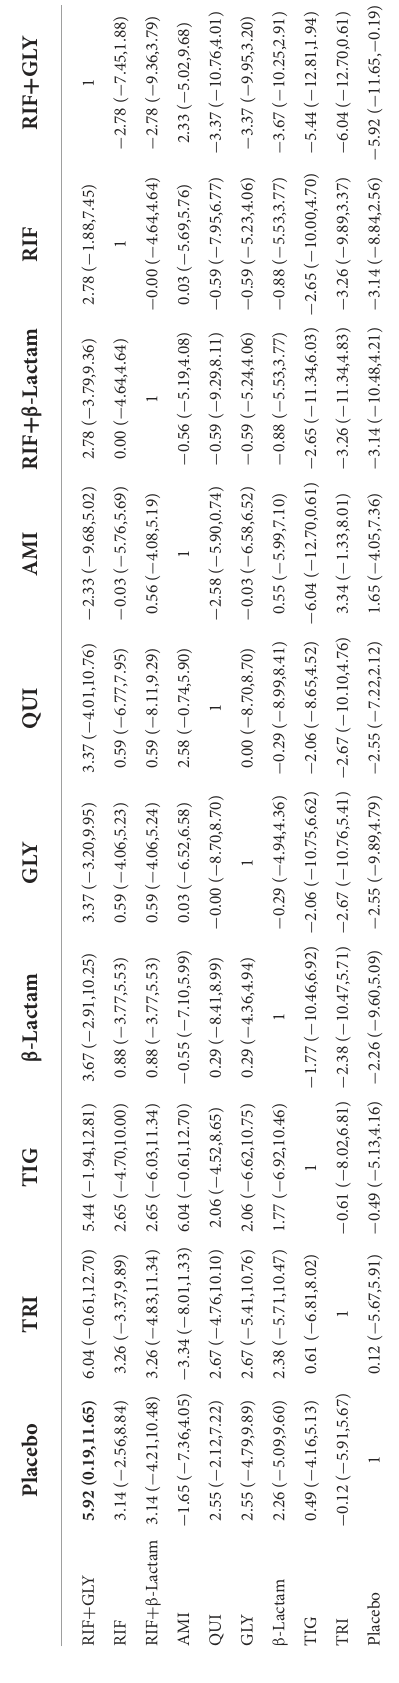
of each pairwise comparison of all the regimens is shown in Supplementary Figure S3A. GLY and AMI had the highest number of studies. From the matrix (Supplementary Table S4), GLY was significantly higher than β -Lactam (SMD: 4.40, 95%CI: 0.32 to 8.47), RIF (SMD: 5.28, 95%CI: 1.89 to 8.67), and TRI (SMD: 6.28, 95%CI: 1.62 to 10.95). The network funnel plot suggested that the small sample effect existed in the comparison between GLY and RIF on the antibiotic concentration of bone after 1h after administration (Supplementary Figure S3B). each pairwise comparison of all the regimens is shown in Supplementary Figure S4A. RIF and GLY had the highest number of studies. From the matrix (Supplementary Table S5), we conducted pairwise comparisons among five